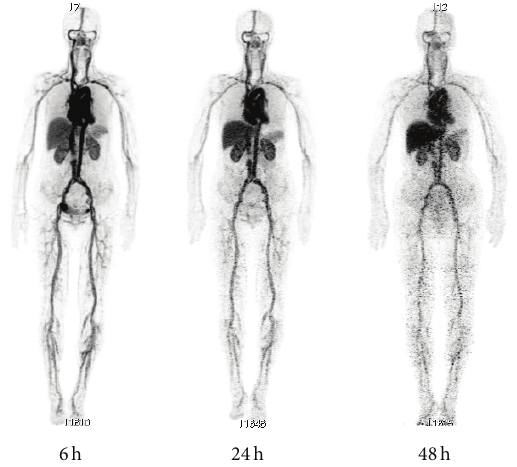
Figure 2: Whole-body 64 Cu-DOTA-trastuzumab PET images at 6, 24, and 48h after